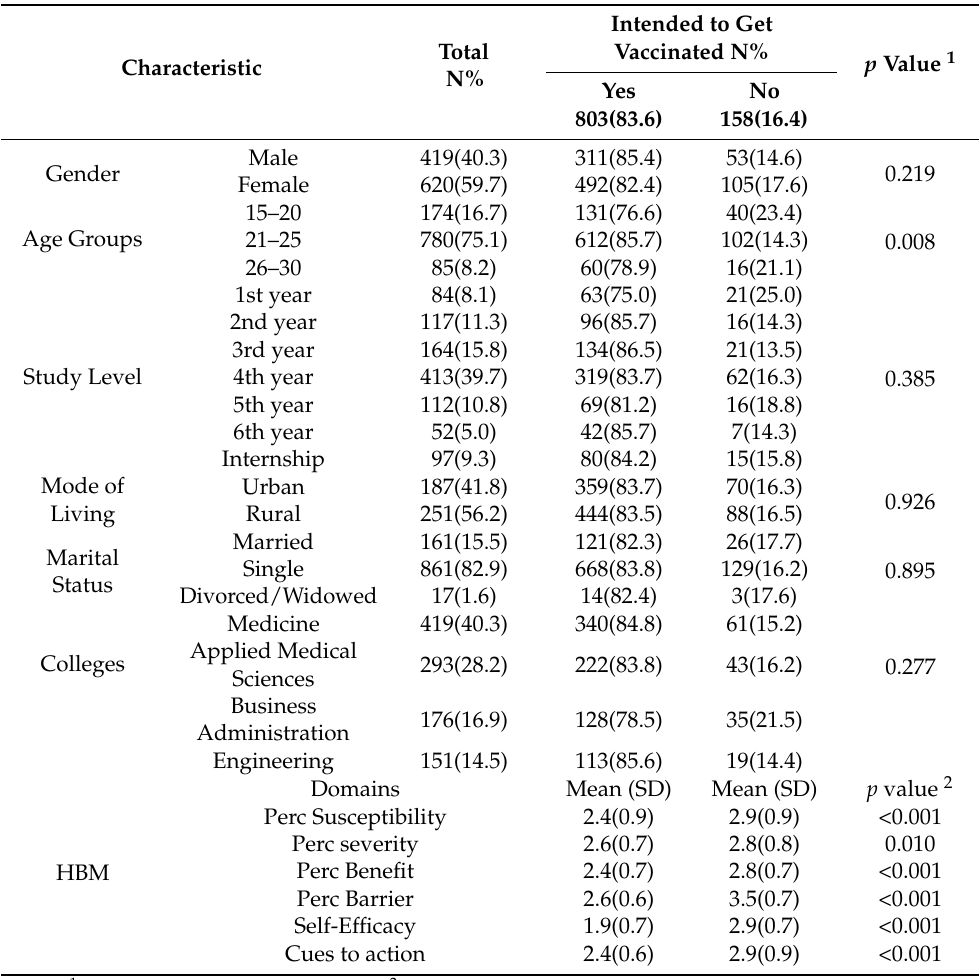
Table 1. Intention to get vaccinated against COVID-19 according to some selected characteristics ( n = 1039). Characteristic